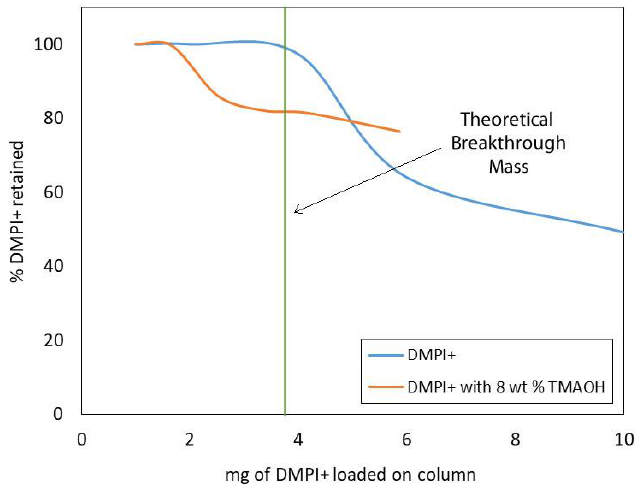
Figure 5. Breakthrough curves for sample solutions containing [DMPIm][NTf 2 ] and [DMPIm][NTf 2 ] with 8 wt% TMAOH showing the effect of competing ions.